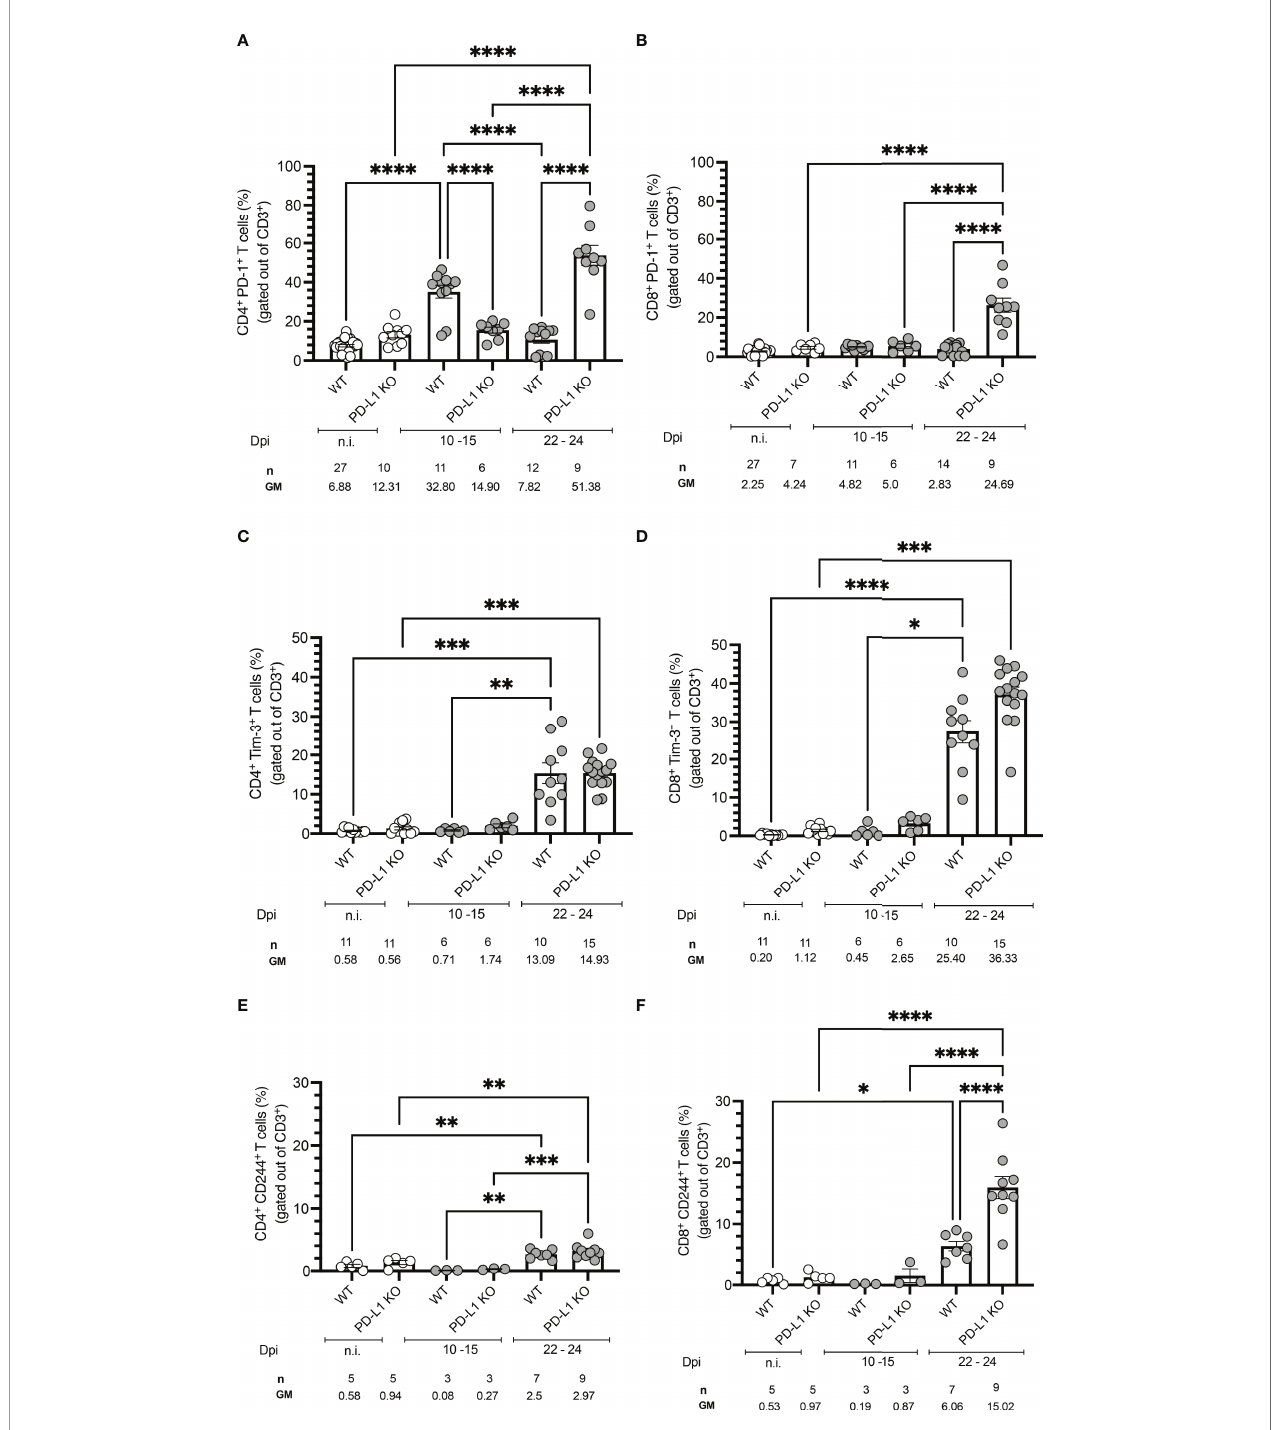
FIGURE 2 | Time course of co-inhibitory receptors expression on T cells from WT and PD-1 KO mice infected with T. cruzi. Time-course experiments showing expression of (A) PD-1 on CD4 + and (B) CD8 + T cells; (C) Tim-3 on CD4 + and (D) CD8 + T cells; (E) CD244 on CD4 + and (F) CD8 + T cells. Error bars indicate standard errors of the means (SEM). Data from three independent experiments. Under the graphs, n is the absolute number of mice used per time point, and the values below are the geometric means (GM). Data were analyzed for statistical signi fi cance using the Kruskal-Wallis test following Dunn´s multiple comparisons test. Asterisks denote P values as described in Methods; ns (not signi fi cant) was not plotted to avoid a busy fi